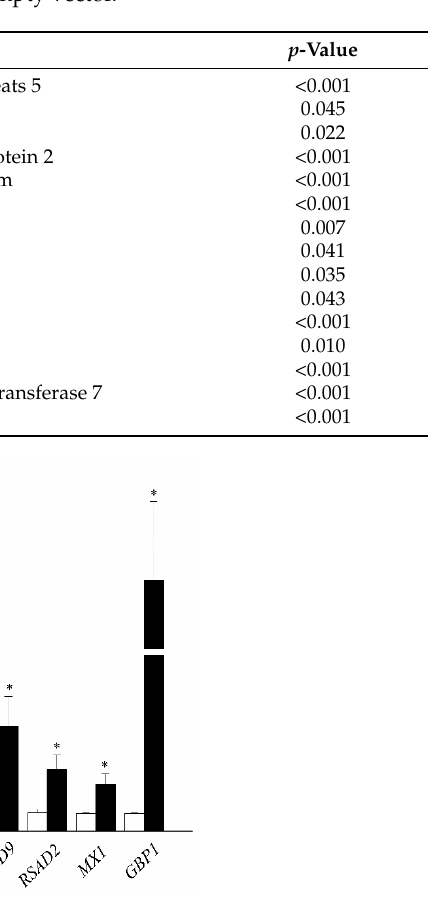
Table 3. The downregulated genes in hepatocytes transfected with pcDNA3.1(+) containing goose OTU deubiquitinase 7A CDS and an empty